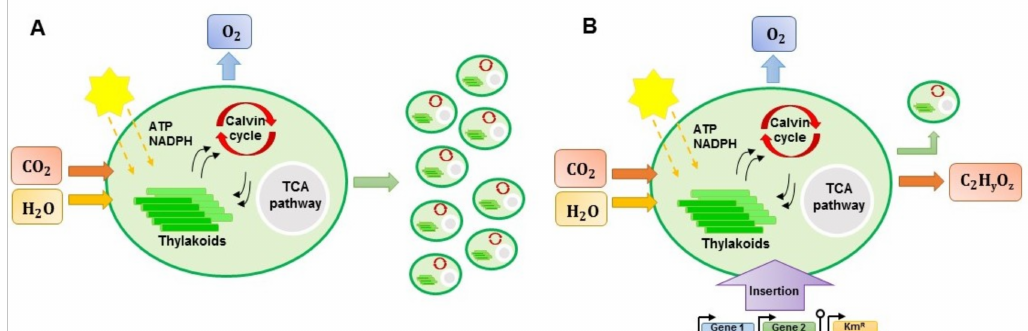
Figure 4. Schematic representation of a cyanobacterial cell factory. ( A ) A non-modified cyanobacterial cell is investing carbon (in form of CO 2 ) and energy sources into growth and the generation of biomass. ( B ) A modified cyanobacterial (here: through the introduction of an alternative biosynthetic pathway) cell factory is investing the majority of the incoming carbon and energy sources into a (excreted) product (here: carbon containing products), allowing only the replacement of dying cells and the maintenance of the cells to be fueled by the native